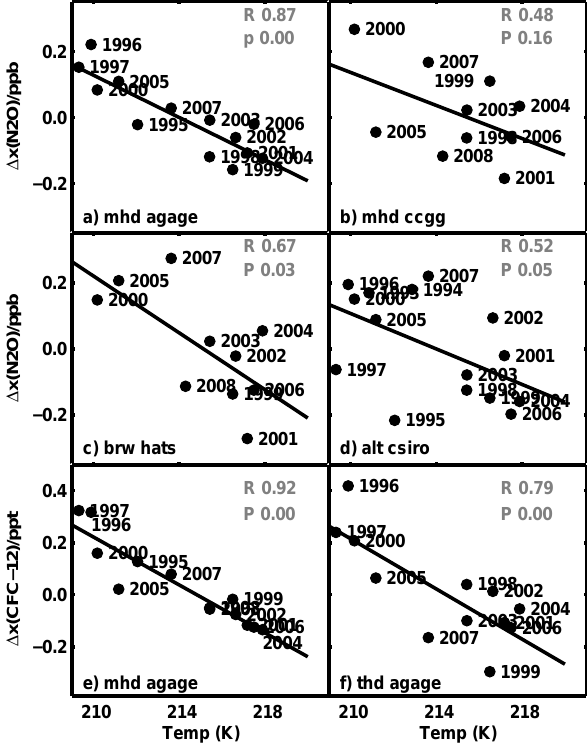
Fig. 7. Detrended N 2 O residuals at the minimum month in the mean annual cycle (September for Alert, August for the other sites) vs. polar winter lower stratospheric temperature, N 2 O (a–d) and CFC-12 (e–f) data are from AGAGE, NOAA/HATS, NOAA/CCGG or CSIRO monitoring sites as indicated on the panels. The Pear- son’s correlation coefficient R and the p value based on a Student’s t distribution for each linear regression are shown, where a value of p ≤ 0.05 is statistically significant (Sokal and Rohlf,